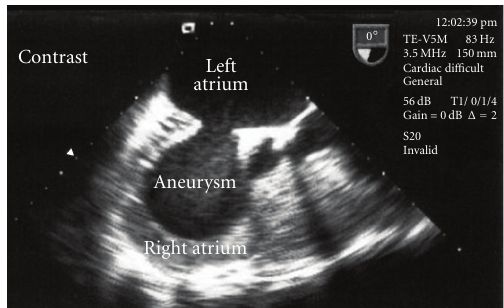
Figure 4: TEE revealing a huge atrial septal aneurysm with automated contrast after bolus injection of agitated saline in the right jugular